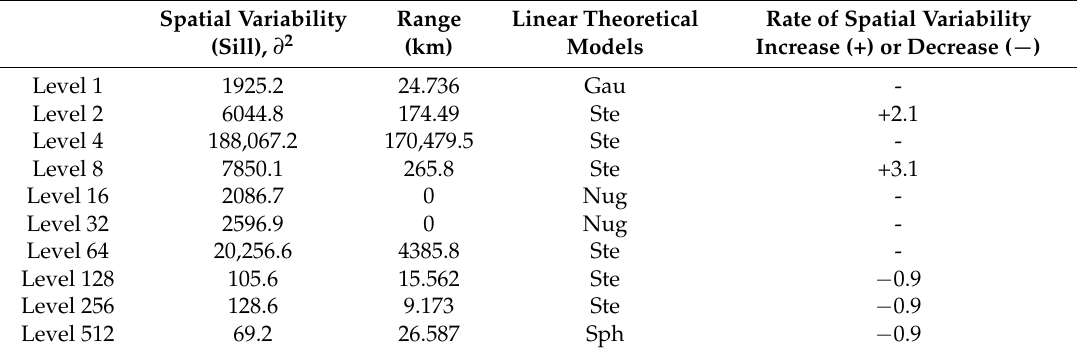
Table 4. Parameters of the fitted variogram